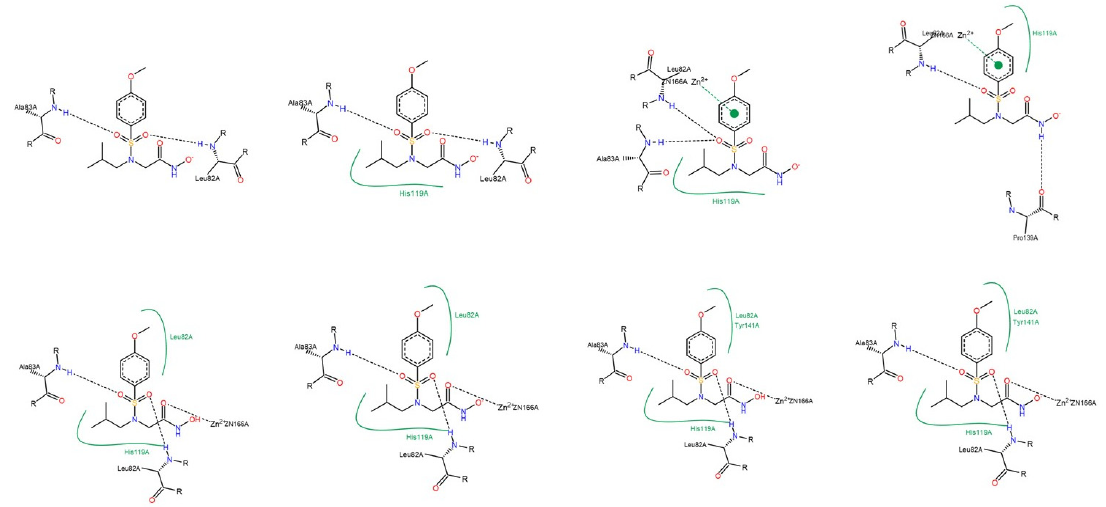
Figure A5. Interactions between NNGH inhibitor and MMP-13, by PoseView calculations.